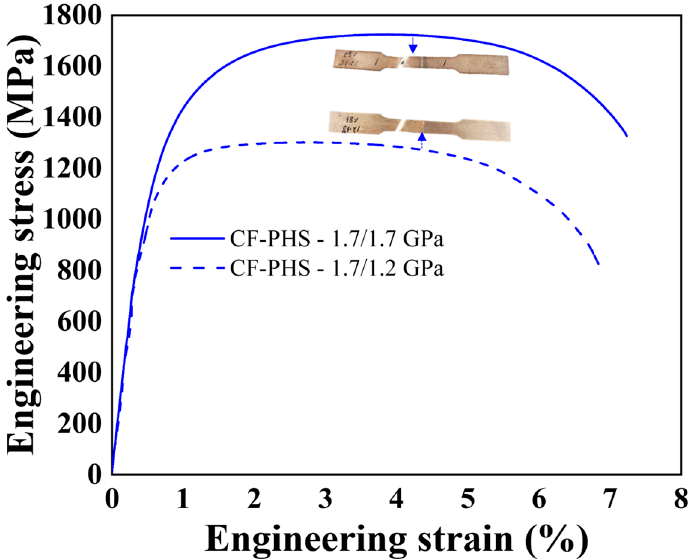
Figure 9. Tensile properties of tailor-welded CF-PHS with the combination of 1.7 GPa/1.7 GPa